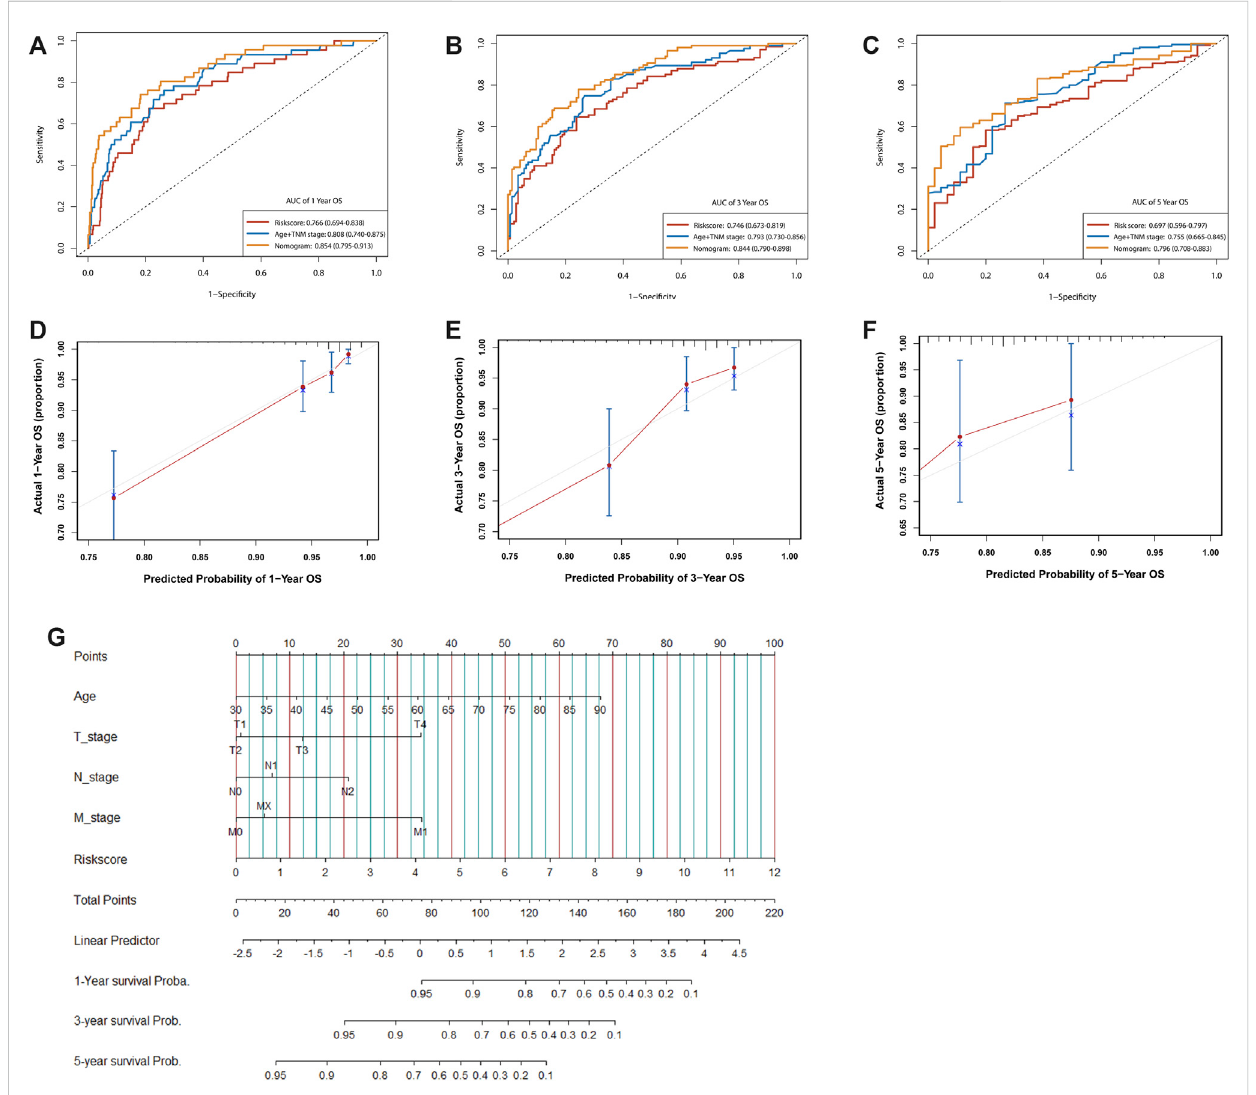
FIGURE 7 Assessment of the prognostic risk model of the m6A-related gene expression signatures and clinical features in CRC. (A – C) Time-dependent receiver operating characteristic (ROC) curves for the nomogram, risk score, and clinical characteristics in the TCGA dataset on predicting 1- (A) , 3- (B) , and 5-year (C) OS. (D – F) The calibration plot of the nomogram predicts the probability of the 1- (D) , 3- (E) , and 5- (F) year OS. (G) Nomogram for predicting the 1-, 3-, and 5-year OS of patients with